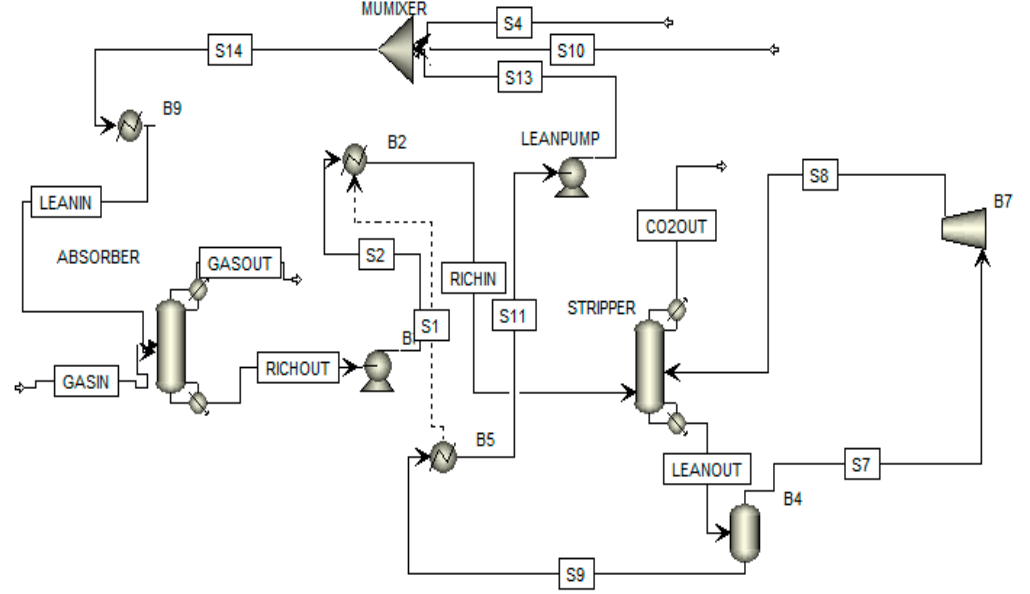
Figure 4. Vapor recompression modification [11].